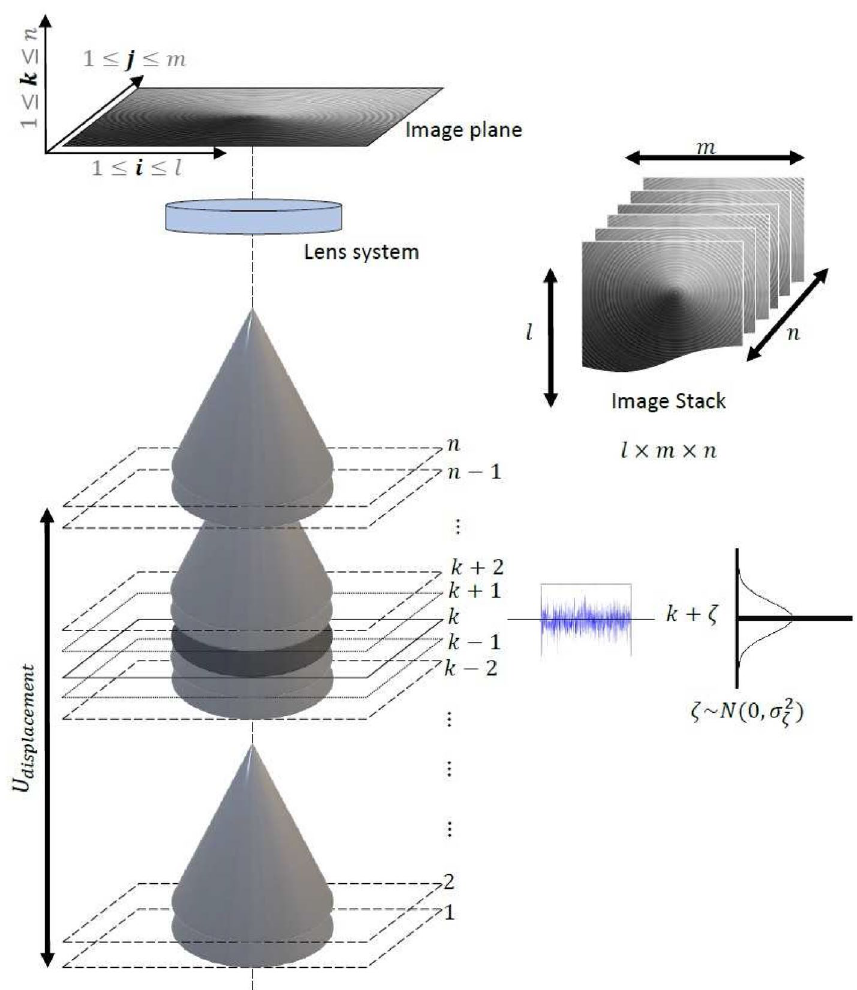
Figure 2. Image acquisition in SFF